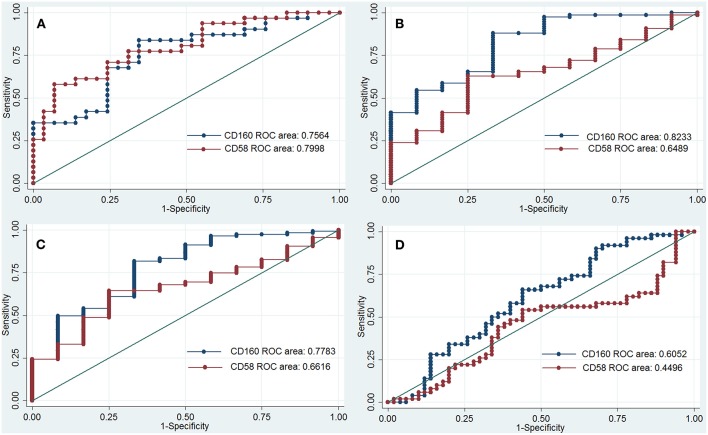
ROC curve to assess the diagnostic roles of CD160 and CD58 in autoimmune diseases. The diagnostic roles of CD160 and CD58 in autoimmune diseases were assessed by receiver operating characteristic (ROC) curve. Transcripts per million (TPM) values of CD58 and CD160 in four RNA-seq datasets including SLE (GSE112087), RA (GSE117769), IBD (GSE112057IBD), and JIA (GSE112057JIA) were used. The area under the ROC curve (AUCs) were shown in the figures. (A) Shows the diagnostic roles of CD160 and CD58 in SLE, and the AUC for CD160 and CD58 in diagnosing SLE is 0.756 (95%CI 0.63–0.88) and 0.799 (95%CI 0.69–0.91), respectively. When the testing threshold for the TPM value of CD160 was defined as 4.35, the sensitivity and specificity for CD160 in diagnosing RA were 75.9 and 67.7%, respectively. (B) Shows the diagnostic roles of CD160 and CD58 in IBD, and the AUC for CD160 and CD58 in diagnosing IBD is 0.823 (95%CI 0.69–0.95) and 0.649 (95%CI 0.50–0.80), respectively. When the testing threshold for the TPM value of CD160 was defined as 8.67, the sensitivity and specificity for CD160 in diagnosing IBD were 83.3 and 58.7%, respectively. (C) Shows the diagnostic roles of CD160 and CD58 in JIA, and the AUC for CD160 and CD58 in diagnosing JIA is 0.778 (95%CI 0.63–0.92) and 0.662 (95%CI 0.53–0.80), respectively. When the testing threshold for the TPM value of CD160 was defined as 8.67, the sensitivity and specificity for CD160 in diagnosing JIA were 83.3 and 53.9%, respectively. (D) Shows the diagnostic roles of CD160 and CD58 in RA, and the AUC for CD160 and CD58 in diagnosing RA is 0.605 (95%CI 0.49–0.72) and 0.449 (95%CI 0.33–0.57), respectively.